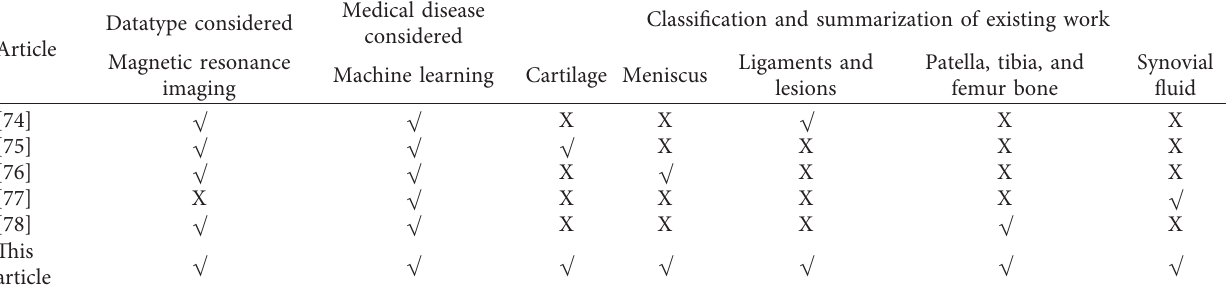
Table 3: Comparative analysis with other published review